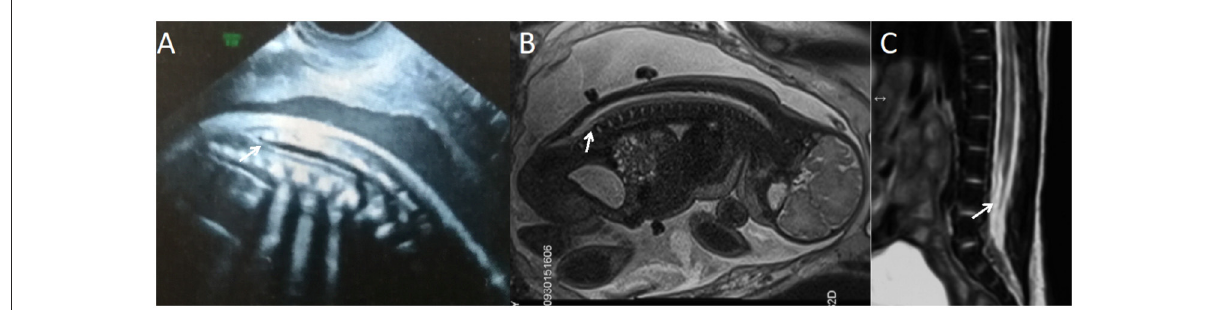
FIGURE3 A fetus with simple spinal tethered cord syndrome. (A) The prenatal ultrasound examination at 20 + 5 weeks of gestation showed the lower conus medullaris. (B) Fetal magnetic resonance imaging (MRI) examination at 20 + 6 weeks of gestation showed the lower conus medullaris. (C)